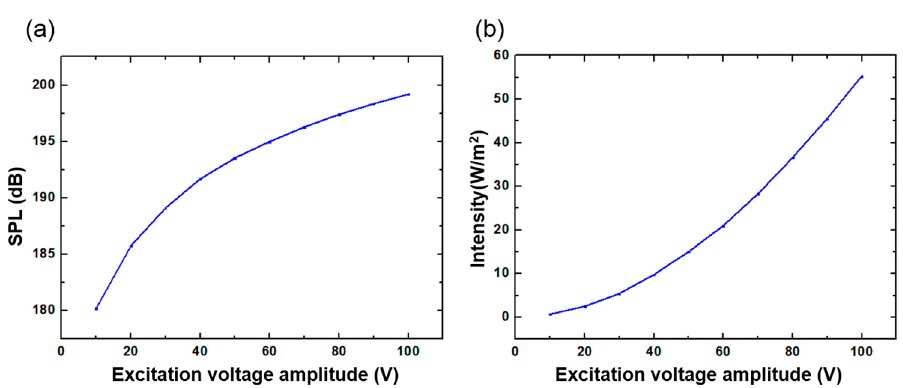
Figure 12. ( a ) The relationship between sound pressure level and excitation voltage amplitude. ( b ) The relationship between sound intensity and excitation voltage amplitude.